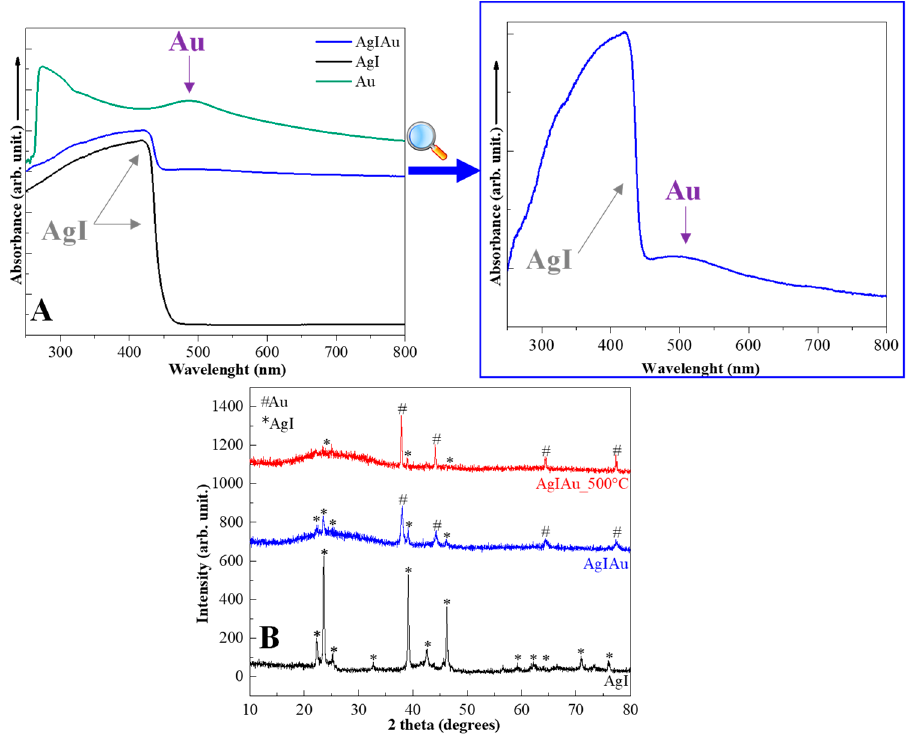
Figure 1. The characterization of the Au nanocages, AgI microcrystals, and AgIAu composite: ( a ) UV–Vis spectra and ( b ) XRD patterns.